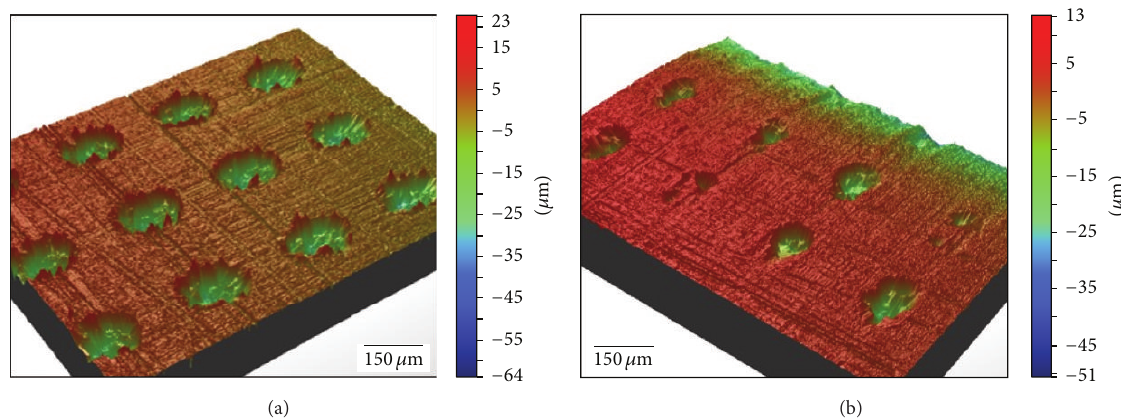
Figure 9: Surface topography—texture #3, die radius: (a) before and (b) after the stamping tests.